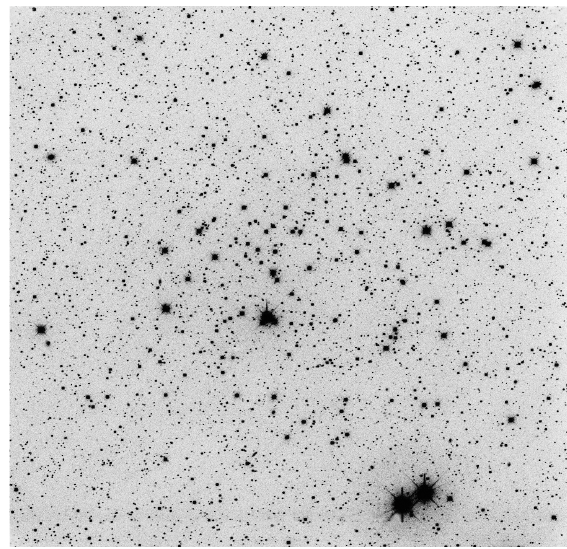
Fig. 1. The map of NGC 752 in a V -band CCD image (1.26 ◦ (cid:2) 1.22 ◦